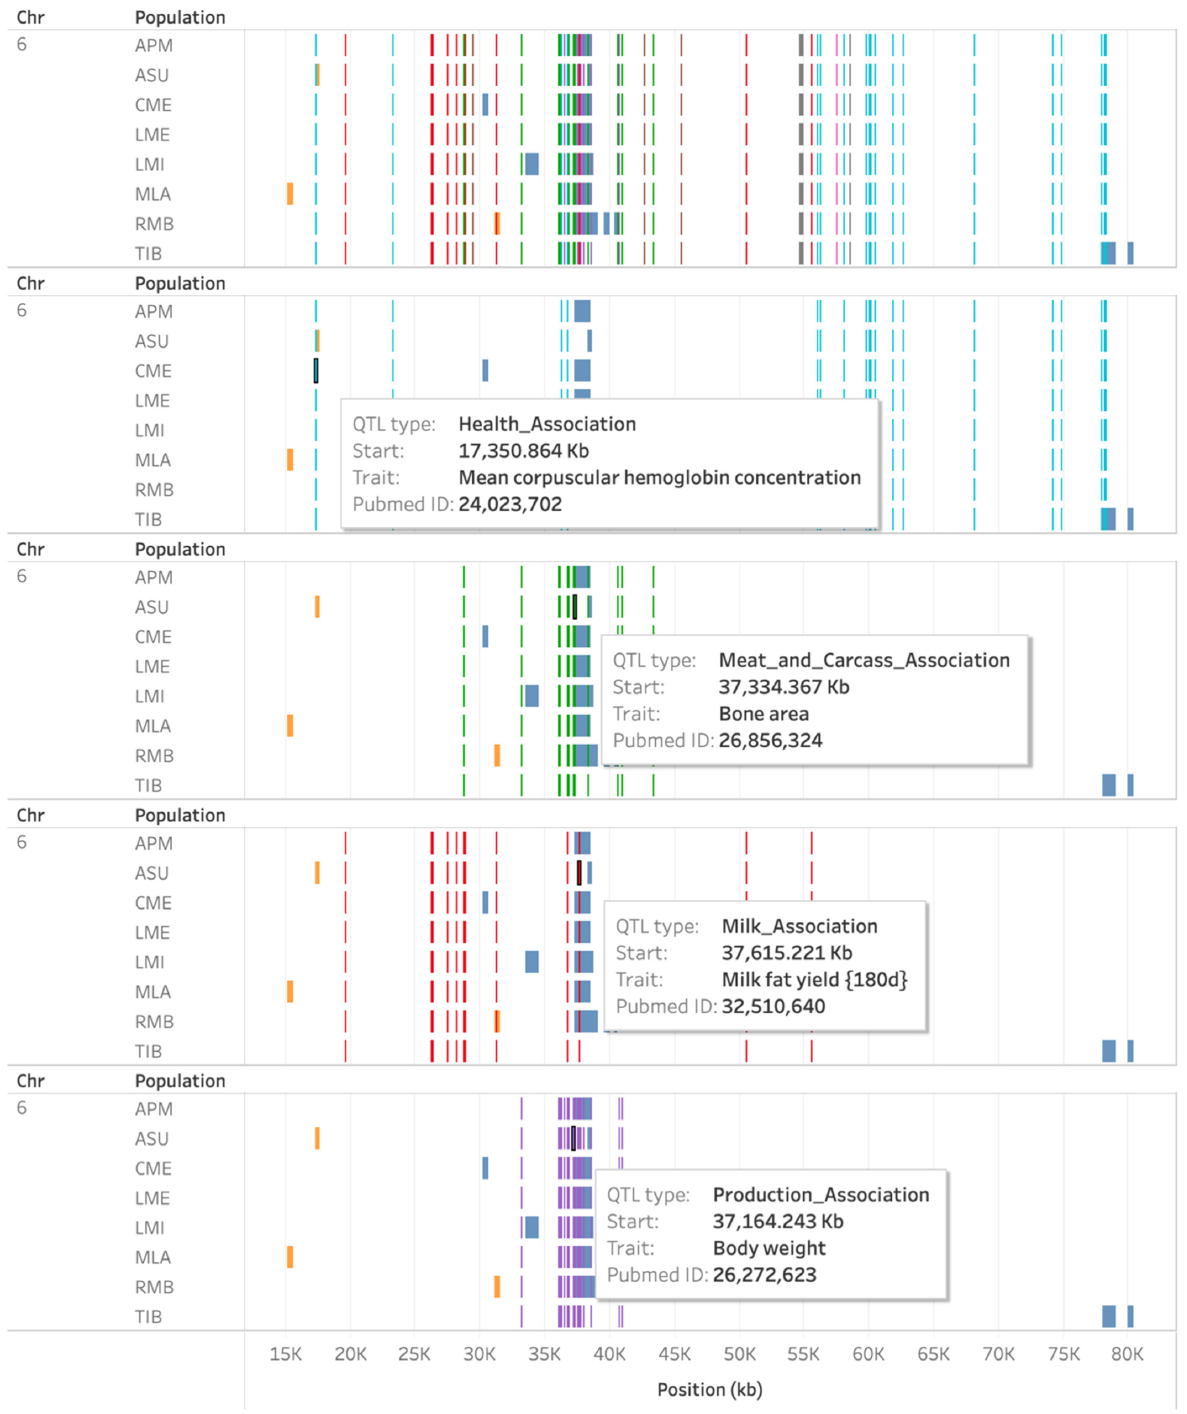
Figure 8. Runs of homozygosity (ROH—blue) and heterozygosity-rich regions (HRR—orange) islands on chromosome 6 plotted against different types of QTLs.